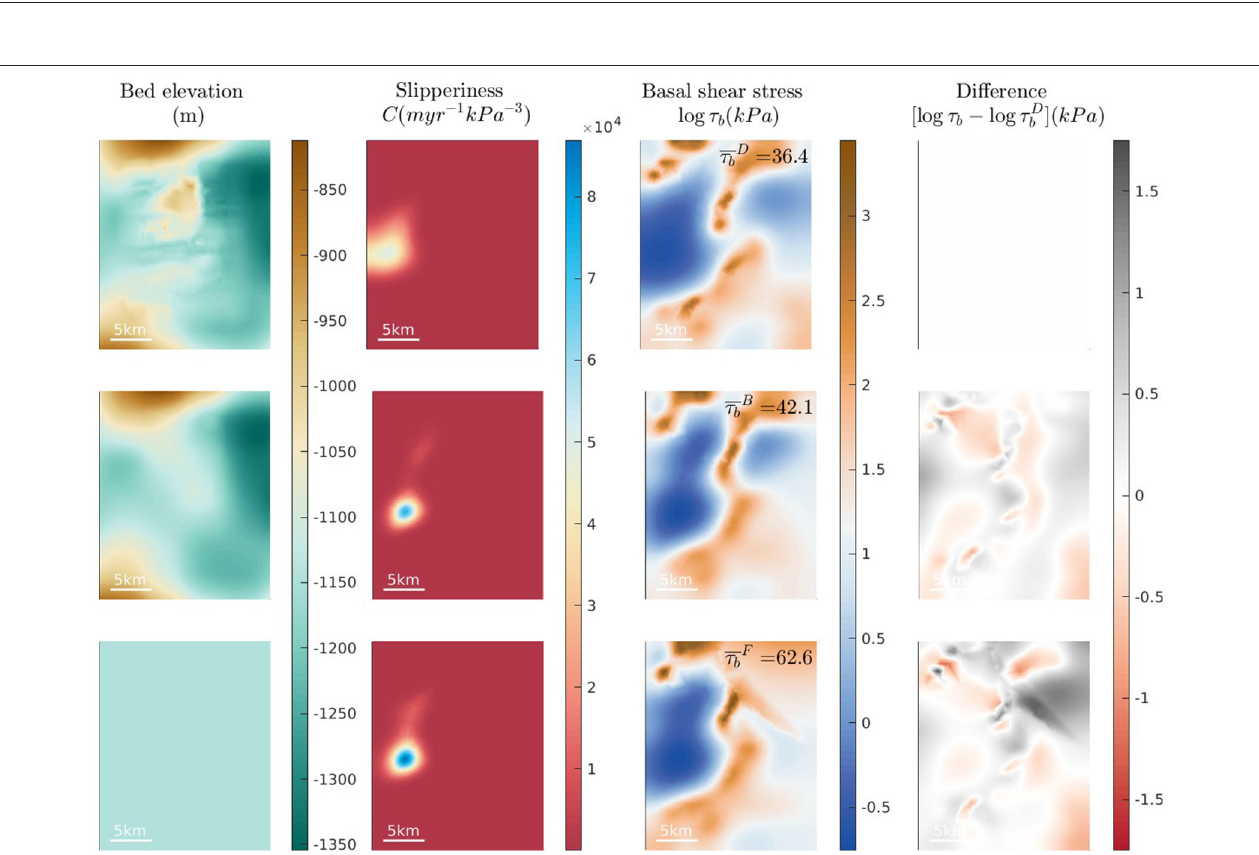
FIGURE 4 | The basal stress field from inversion of surface data over iSTARt7. Three results are shown using three different resolutions of bed elevation data (left column). Mean basal shear stress for each is given.